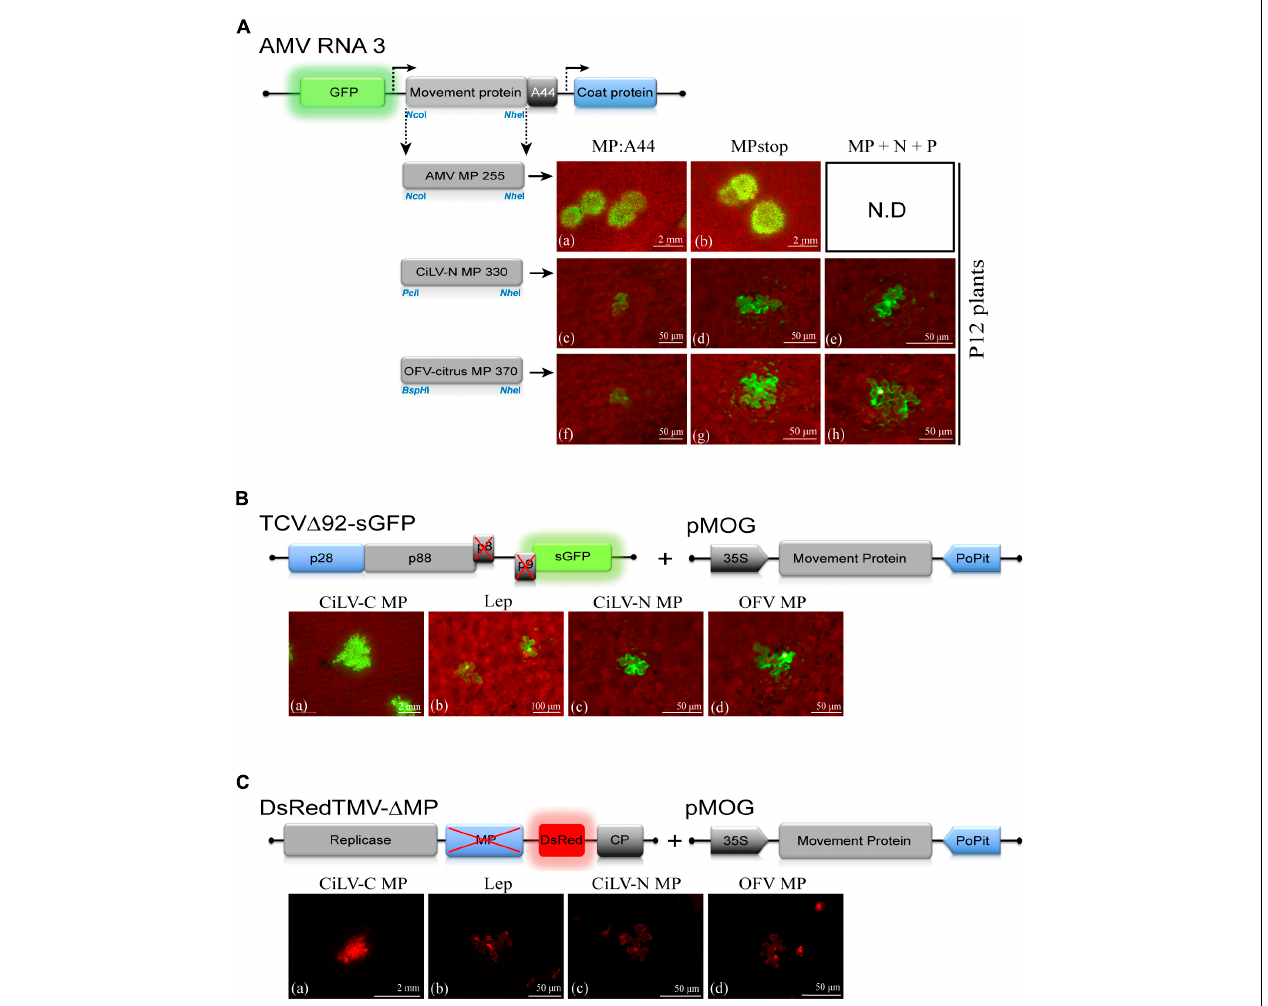
FIGURE 6 | The dichorhavirus MPs do not complement the cell-to-cell movement of the alfalfa mosaic virus (AMV), turnip crinkle virus (TCV) and tobacco mosaic virus (TMV) infectious clones. (A) Analysis of the cell-to-cell transport of the hybrid AMV RNA 3 in which its movement protein (MP) gene was exchanged with the corresponding genes (MPs) of citrus leprosis virus N (CiLV-N) and orchid fleck virus citrus strain (OFV-citrus). Individual GFP-cell foci are observed in P12 leaves inoculated with RNA 3 transcripts from pGFP/A255/CP derivatives carrying the heterologous MPs, fused with the C-terminal 44 residues of the AMV MP (A44) (c,f) or lacking the A44 (MPstop) (d,g). Infection foci are demonstrated for the AMV MP wild-type and the mutated version expressing the N-terminal 255 residues (positive control, a,b). Representative images of all combinations from co-inoculation of AMV RNA 3 transcripts carrying the N, P, and MP dichorhavirus genes are presented (e,h). The schematic representation shows the GFP/A255/CP AMV RNA 3, in which the open reading frames, represented by large boxes, correspond to the green fluorescent protein (GFP), the movement protein (MP), and the coat protein (CP). Short box corresponds to the C-terminal 44 amino acids of the AMV MP, meanwhile arrows represent subgenomic promoters. The numbers after the viral acronym represent the total amino acid residues of the corresponding MP. The Nco I, Bsp HI, Pci I, and Nhe I restriction sites used for insertions of the MPs are indicated. White bars correspond to 50 µ m–2 mm. Each infection foci image is representative of the inoculation of three leaves per plant and two plants inoculated for each chimeric AMV construct. ND, non-determined. (B) TCV assay based on the complementation of the movement-deficiency phenotype of a TCV MP mutant (TCV (cid:49) 92-sGFP). Three N. benthamiana leaves per plant were infiltrated with pMOG 800 constructs carrying CiLV-C MP (a) (positive control) and MPs of CiLV-N (c) and OFV-citrus (d) or pMOG-Lep (b) as negative control. Infectious RNA transcript of the TCV (cid:49) 92-sGFP construct was mechanically inoculated 1 day post agroinfiltration. Cell-to-cell movement was evaluated at 3 days post inoculation. Viral movement complementation is visualized for CiLV-C MP expression (a); meanwhile, only individual foci-cells are visualized for the leaves inoculated with the constructions expressing the dichorhavirus MPs (c,d). The schematic representations show: (1) the TCV RNA, in which the open reading frames are represented by the boxes. The p28 (blue box) and p88 (gray) code for replication proteins. The p8 and p9 encode movement proteins (black box) and the green fluorescent protein (GFP) is represented in the place of the viral coat protein. An X in the p8 and p9 indicates protein deletion. (2) pMOG expression cassette used for the ectopic expression of the MPs indicated. The genes were cloned between CaMV constitutive 35S promoter (black box) and potato proteinase inhibitor terminator (PoPit, blue box). White bars correspond to 50 µ m–2 mm. (C) TMV trans-complementation assay based on a TMV MP defective mutant expressing the red fluorescent protein (DsRed) (DsRedTMV- (cid:49) MP). N. benthamiana leaves (three per plant) were infiltrated with an agrobacterial culture containing the binary pMOG constructs carrying CiLV-C MP (a), CiLV-N MP (c), OFV-citrus MP (d), or pMOG-Lep (b) as negative control. At 1 day post agroinfiltration, all infiltrated leaves were inoculated with DsRedTMV- (cid:49) MP derived transcripts. The schematic representations show the pMOG cassette above described and the DsRedTMV- (cid:49) MP RNA, in which the ORFs are represented by boxes corresponding to replicase (gray box), deleted MP (blue box), DsRed (red box), and the capsid protein (CP, gray box). White bars correspond to 50 µ m–2 mm.